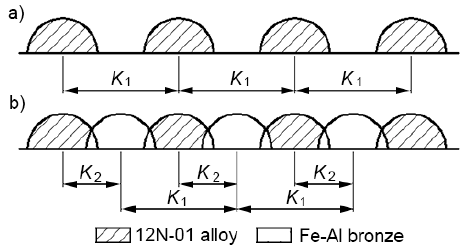
Figure 10. The scheme of depositing a single composite layer: ( a ) tracks of 12N-01 alloy; ( b ) layer of 12N-01 alloy and Fe–Al